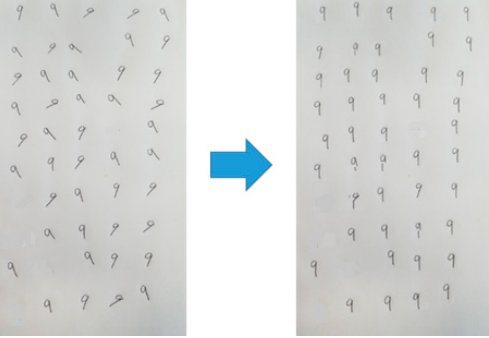
Figure 22. Tilt correction examples of “9” following the proposal ( left : original, right : tilt correction results).